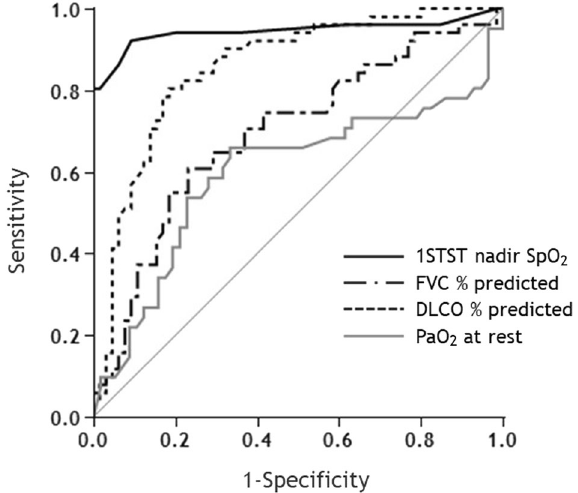
Fig. 3 ROC curve to predict the desaturation during the 6MWT. ROC receiver operating characteristic, 1STST 1 min sit-to-stand test, 6MWT 6 min walk test, SpO 2 pulse oxygen saturation, FVC forced vital capacity, DLCO diffusion lung capacity for carbon monoxide, PaO2 arterial partial pressure of oxygen, AUC area under the curve. Table 3. Diagnostic ability to identify desaturation during 6MWT in all patients.